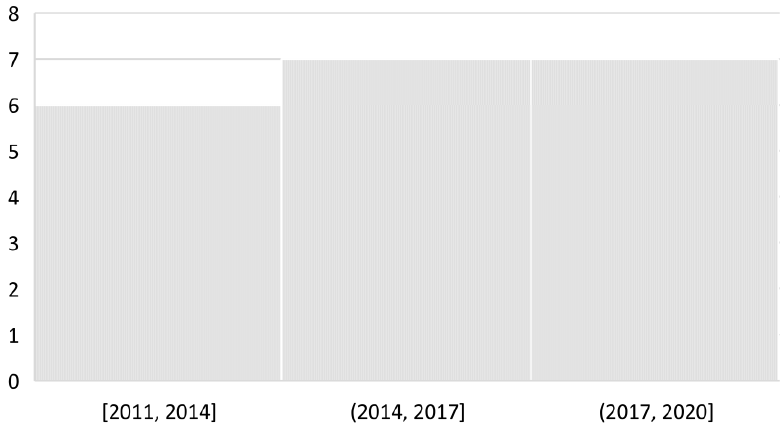
Figure 2. Frequency of studies per period of time.